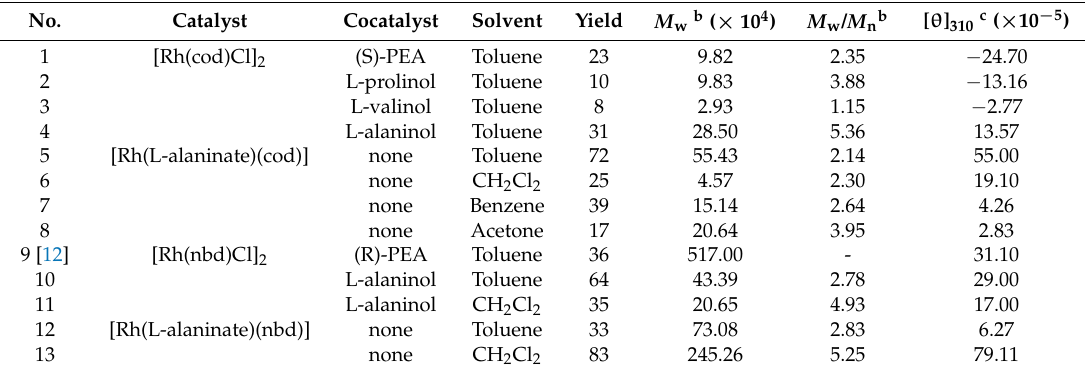
Table 1. Asymmetric polymerizations of DoDHPA with various chiral Rh catalysts a